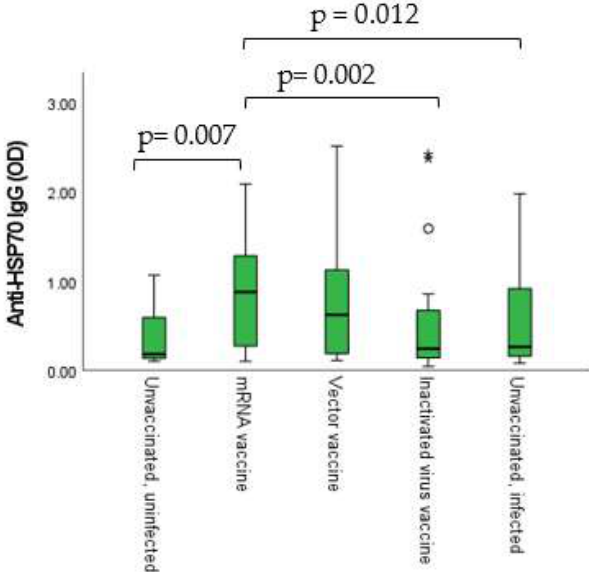
Figure 8. Vaccination group-based comparison of anti-HSP70 IgG titers. Anti-HSP70 IgG absorbance (OD) results were handled as continuous integers, non-normally distributed and the alterations of titers were considered. Total n =185.